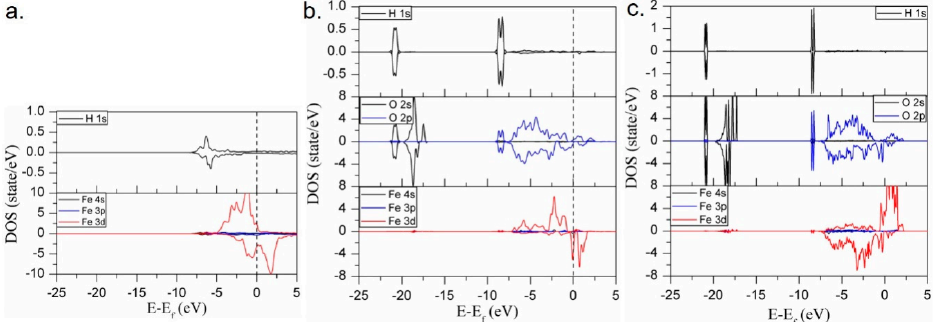
Figure 6. Density of state of H interacting with different adsorption sites: ( a ) Fe sites of Fe (110); ( b ) O sites of Fe 3 O 4 (111)-Fe tet1 and ( c ) O sites of Fe 3 O 4 (001)-B.